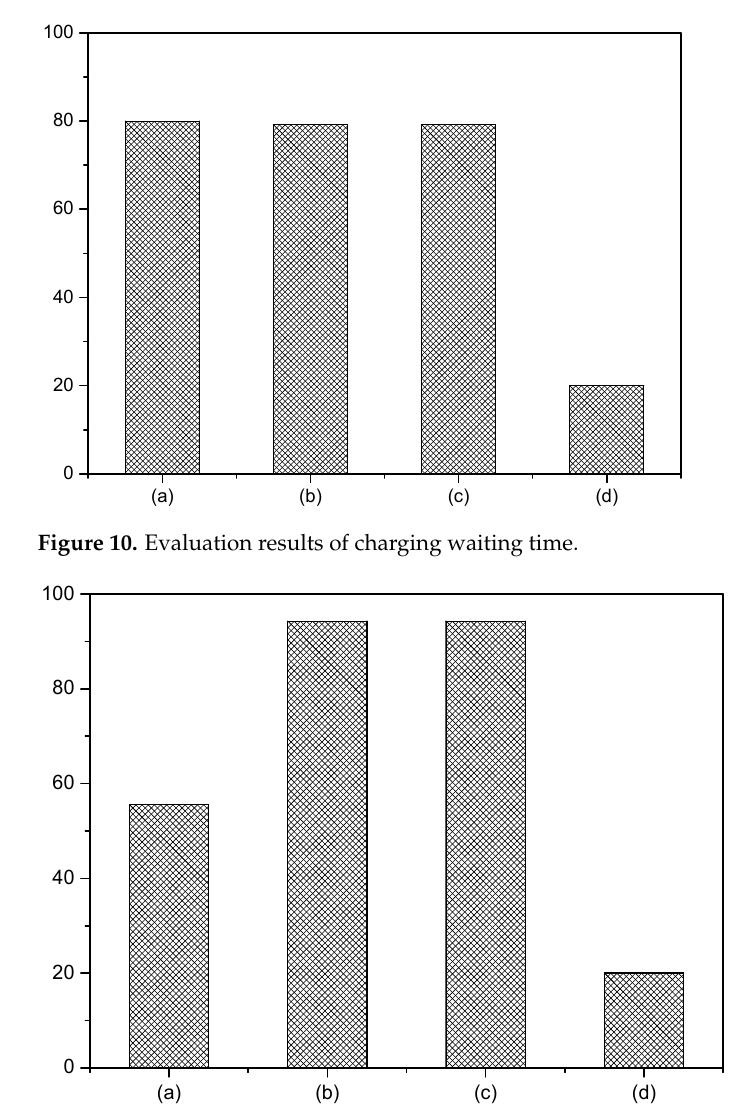
Figure 11. The Evaluation results of utilization rate of FCSs.